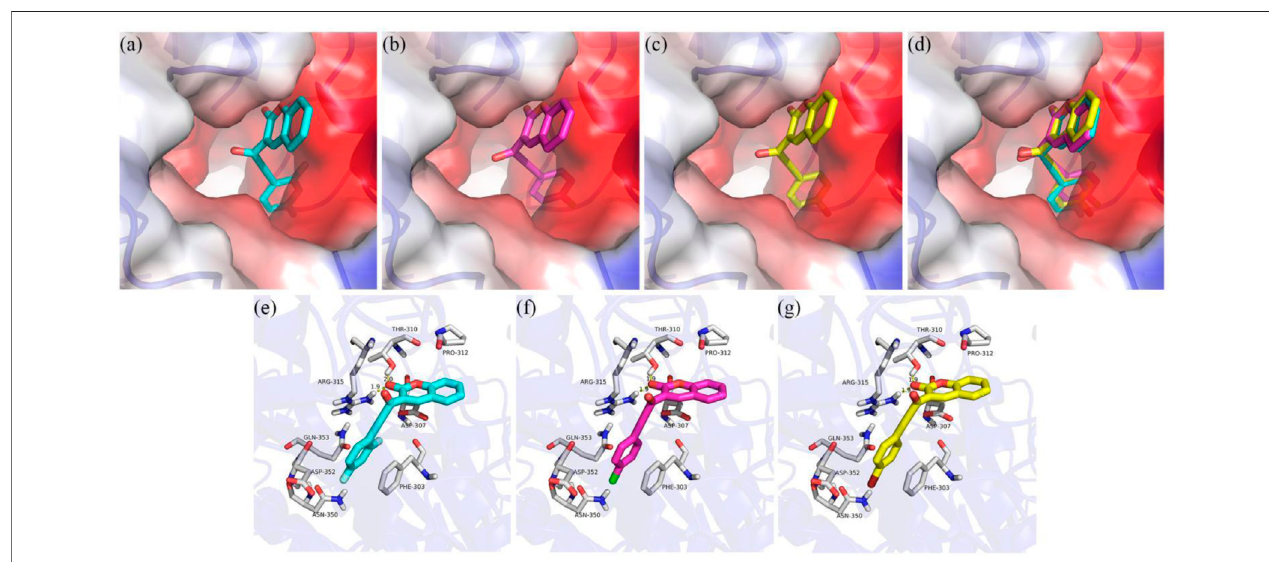
FIGURE4 | Moleculardockingofcompounds 3d , 3f and 3i with α -glucosidase. (A) Compound 3q in theactive pocket (B) ; Compound 3t inthe active pocket (C) ; compounds 3j , 3q and 3t in the active pocket of α -glucosidase (D) ; 2D view of 3j with α -glucosidase (E) ; 2D view of 3q with α -glucosidase (F) ; 2D view of 3t with α - glucosidase (G)